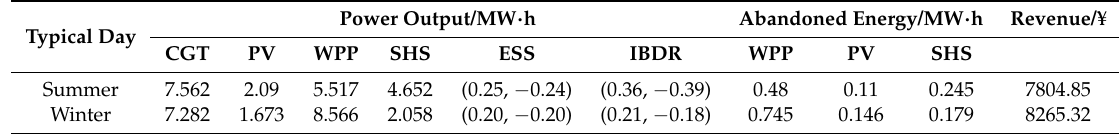
Figure 6. Output distribution of VPP power generation on typical day: ( a ) summer and ( b ) winter. Table 2. Scheduling results of VPP operation in typical load day.